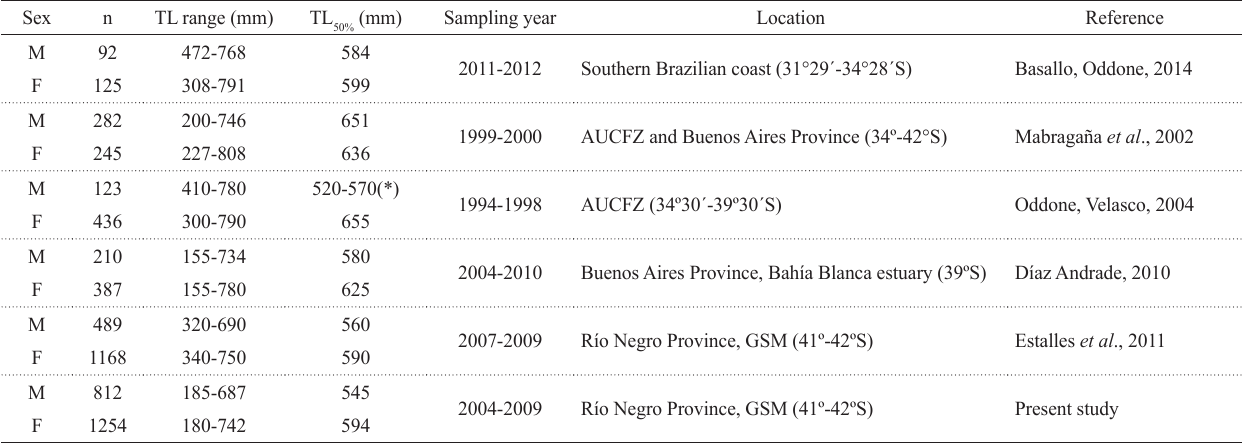
Tab. 5. Comparative size ranges and sizes at maturity reported for Sympterygia bonapartii from San Matías Gulf (Argentina). TL50%: Size at which 50% of the individuals reach maturity. AUCFZ: Argentine-Uruguayan Common Fishing Zone. GSM: San Matías Gulf. Estimated using clasper length